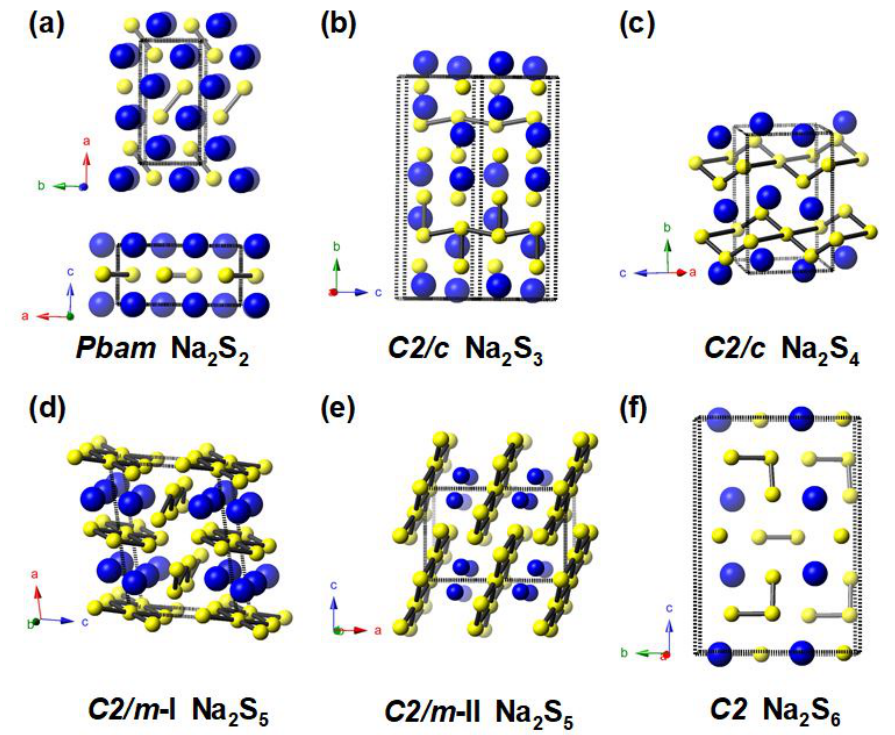
Figure 7. Predicted crystal structures of Na 2 S n ( n = 2–6) phases under pressure whose sulfur sublattices were comprised of molecular (dimers, trimers) or one-dimensional (chains, corner or edge sharing squares, or corner sharing cyclohexane-like rings) motifs: ( a ) top and side view of Pbam -Na 2 S 2 at 200 GPa; ( b ) C 2/ c -Na 2 S 3 at 100 GPa; ( c ) C 2/ c -Na 2 S 4 at 100 GPa; ( d ) C 2/ m -I Na 2 S 5 at 100 GPa; ( e ) C 2/ m -II Na 2 S 5 at 200 GPa; and ( f ) C 2-Na 2 S 6 at 100 GPa. Sodium atoms are colored blue, and sulfur atoms are